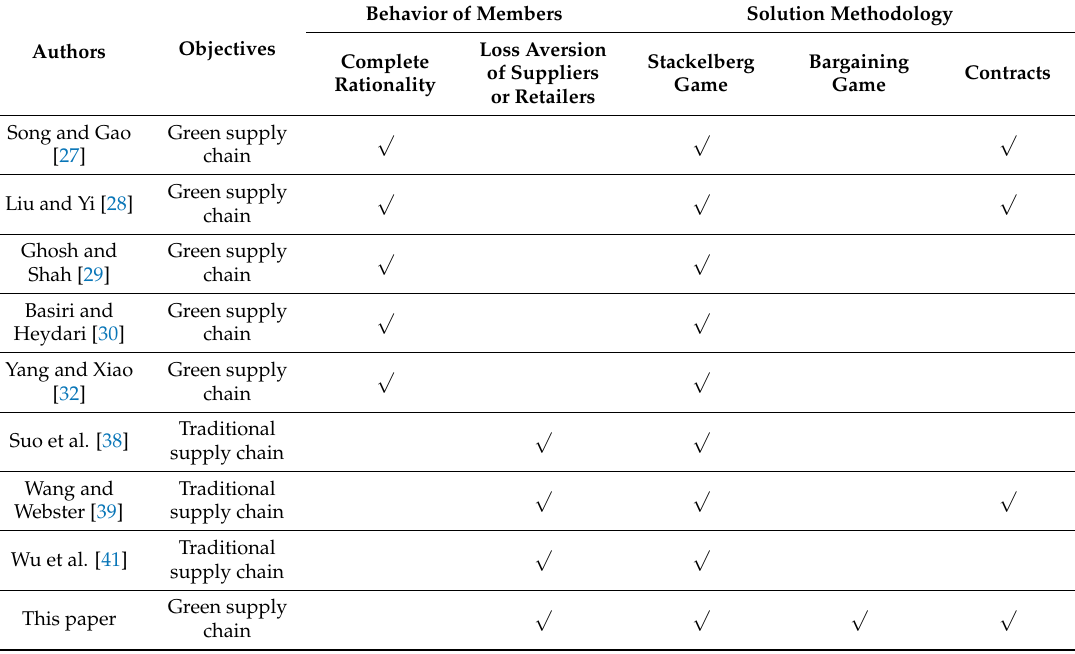
Table 1. The classification of literature in supply chain